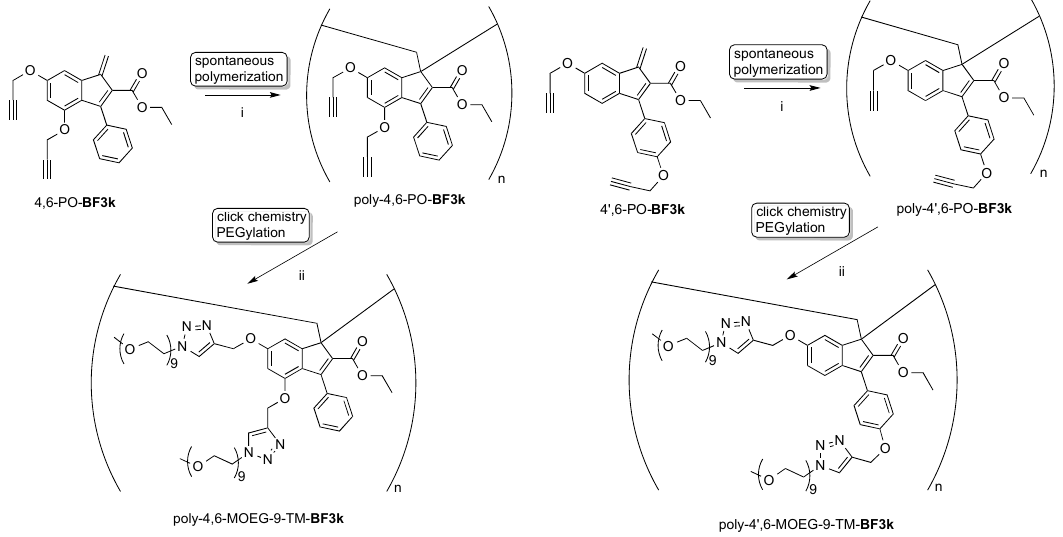
Scheme 1. “Grafting onto” approach to PPBFB poly-4,6-MOEG-9-TM- BF3k ( left ) and poly-4’,6- MOEG-9-TM- BF3k ( right ). Reagents: (i) solvent elimination; (ii) CH 3 (OCH 2 CH 2 ) 9 N 3 , CuBr, DIPEA, THF (or DMF), MW.